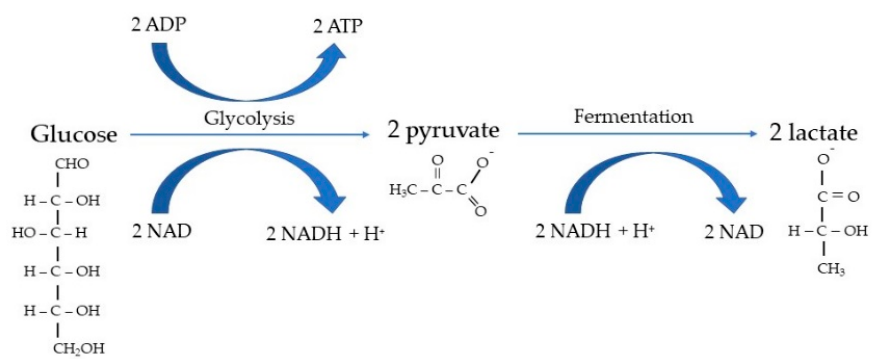
Figure 1. Schematic representation of lactic acid fermentation.